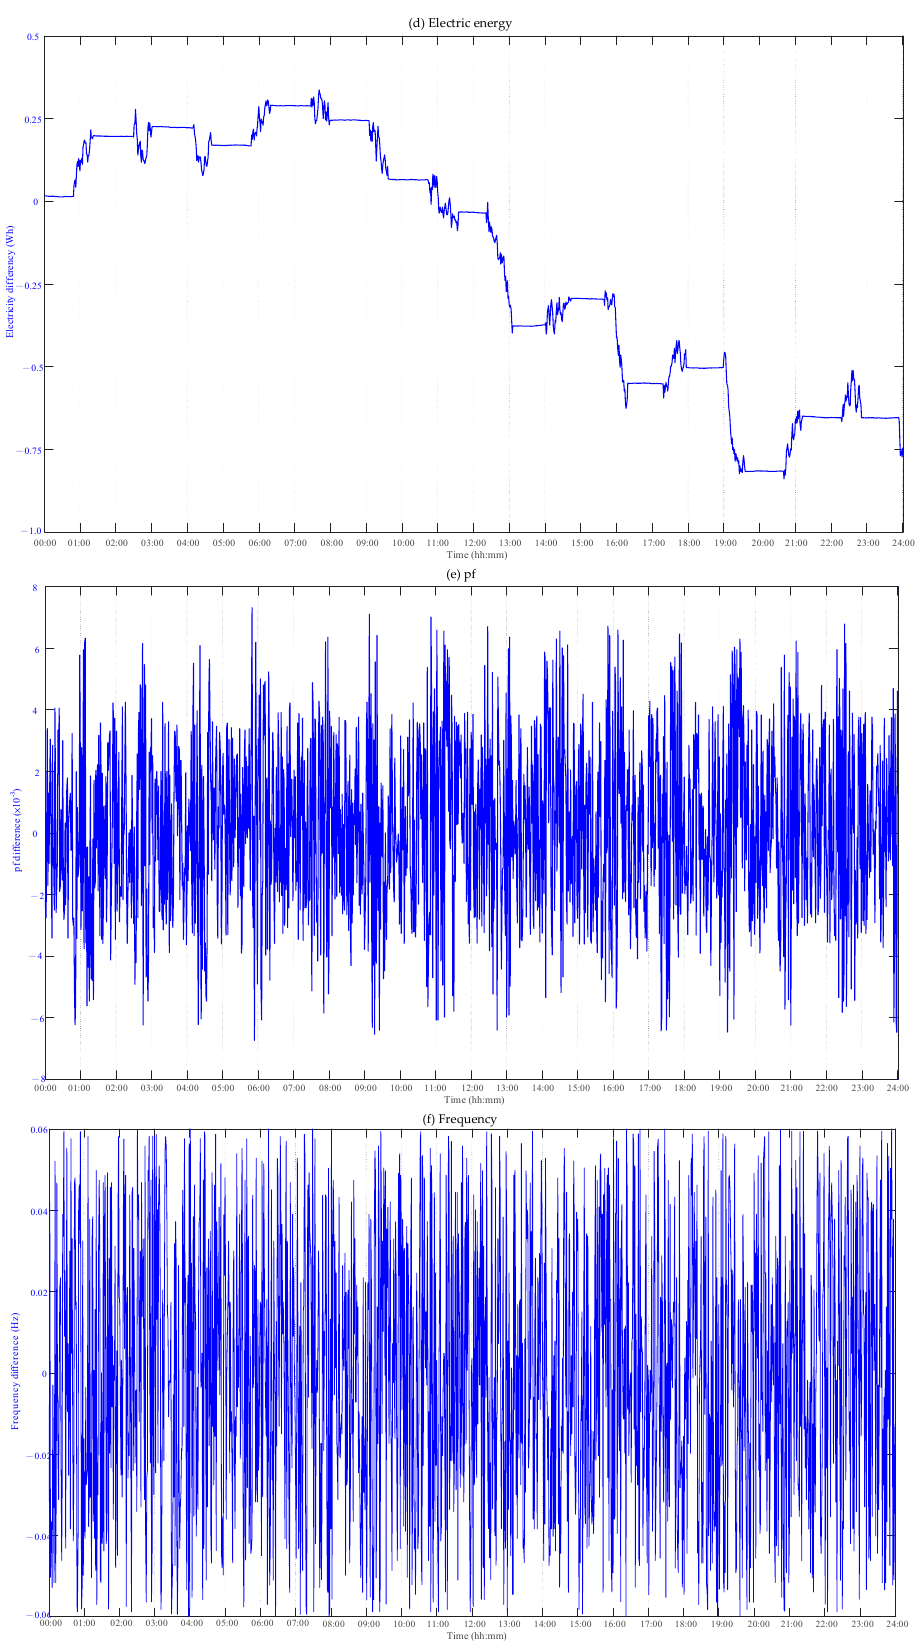
Figure 6. Close agreement analysis for 24 h measurement results for refrigerator: ( a ) Voltage; ( b ) Current; ( c ) Electric power; ( d ) Electric energy; ( e ) Power factor (pf); ( f ) Frequency (Hz).